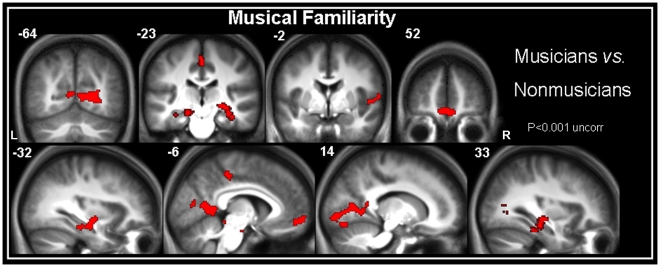
Higher activations in musicians vs. nonmusicians during the musical familiarity task.Areas of significantly stronger activation in musicians, compared with nonmusicians, during the musical familiarity task (see also Table 2). The bilateral anterior portion of the hippocampus (extending to the entorhinal cortex on the left and into the parahippocampus on the right), the bilateral calcarine (extending to the occipital and lingual gyri) and orbitomedial frontal gyri, the middle cingulate cortex and the bilateral superior temporal areas, including Heschl's gyri, were associated with increased familiarity for the musicians. Contrasts are displayed at p< 0.001 (uncorrected) and superimposed onto the average of normalized brains using MRIcron software. Abbreviations: L = left hemisphere, R = right hemisphere.